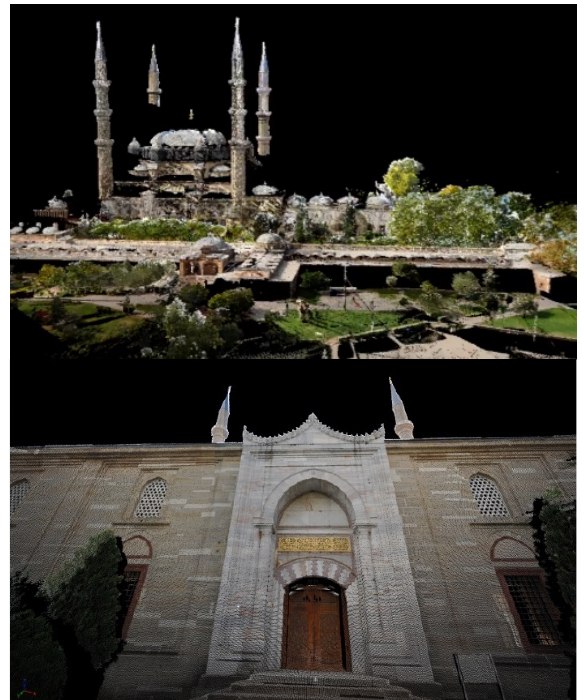
Figure 3. Part of the coloured point cloud of the Edirne mosque – overview (top) and detail (bottom)